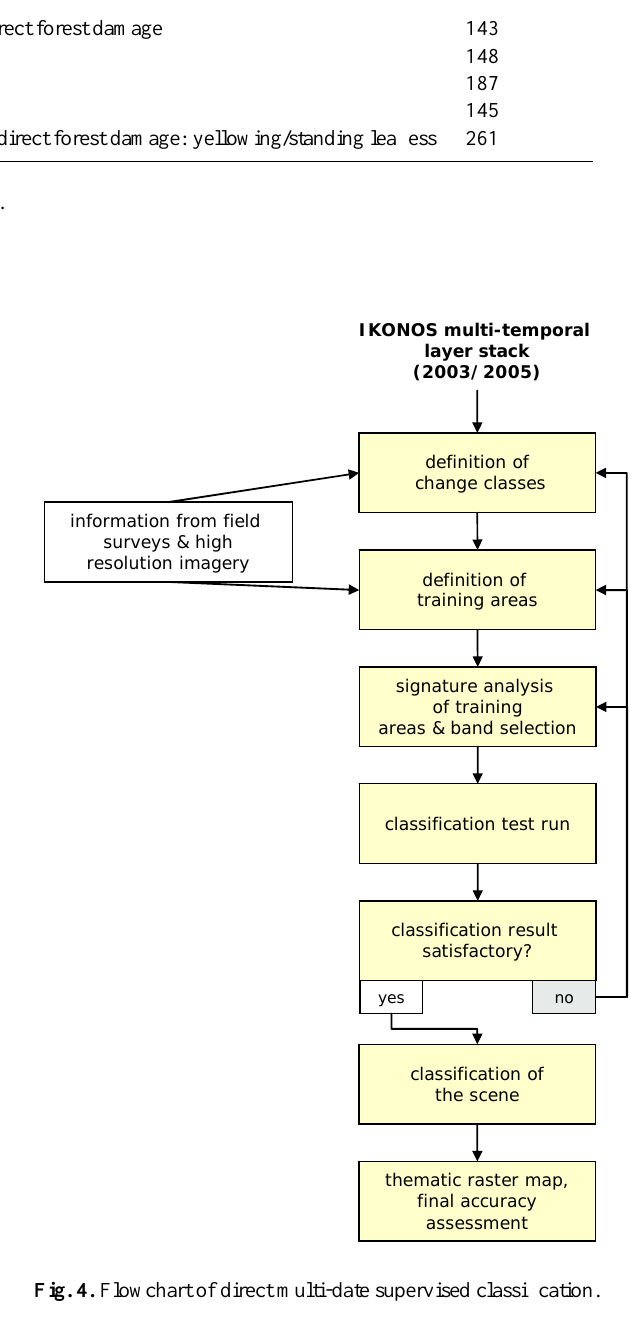
Fig. 4. Flowchart of direct multi-date supervised classification.